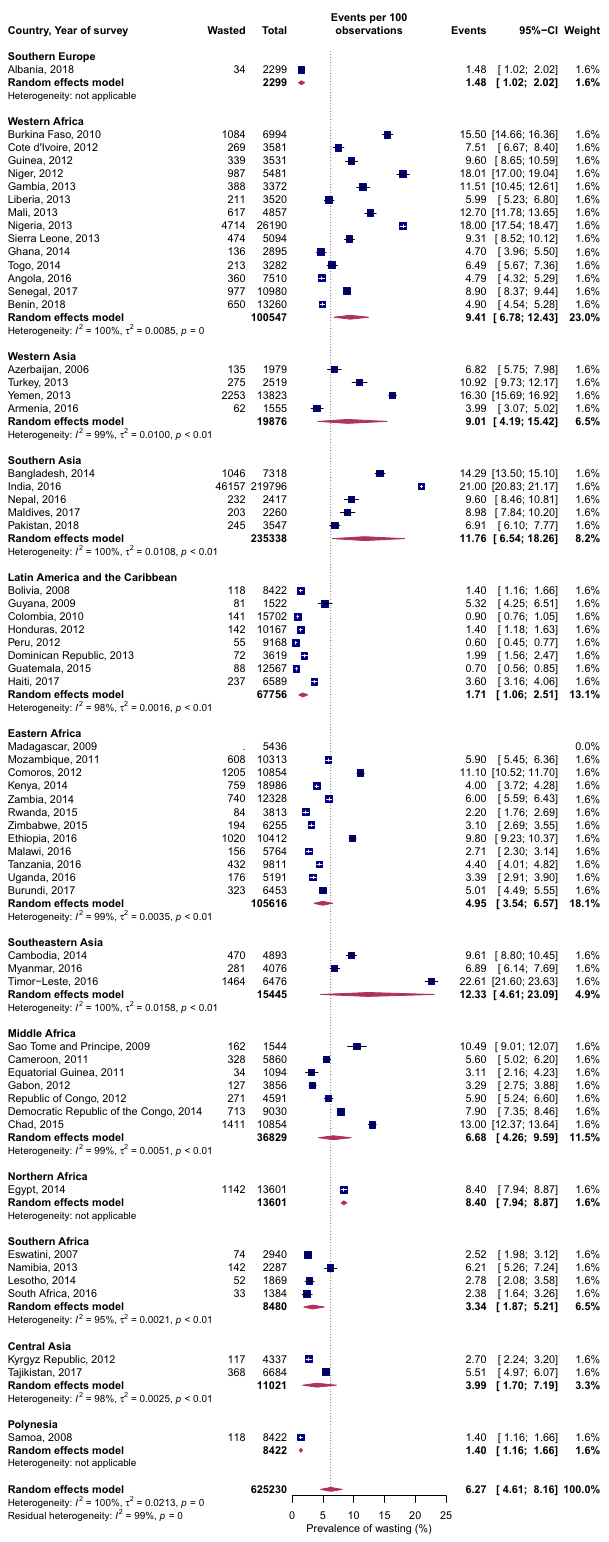
Figure 3. Forest plot of wasting prevalence by UN subregions of LMICs: event values represent the number of cases of wasting expressed as a percentage. Blue squares and their corresponding lines are the point estimates and 95% confidence intervals (95% CI). Maroon diamonds represent the pooled estimate of the prevalence for each subgroup (width denotes 95% CI). Weights are from the random-effects meta-analysis model described by DerSimonian and Laird 20 ( p for interaction comparing the different subgroups <